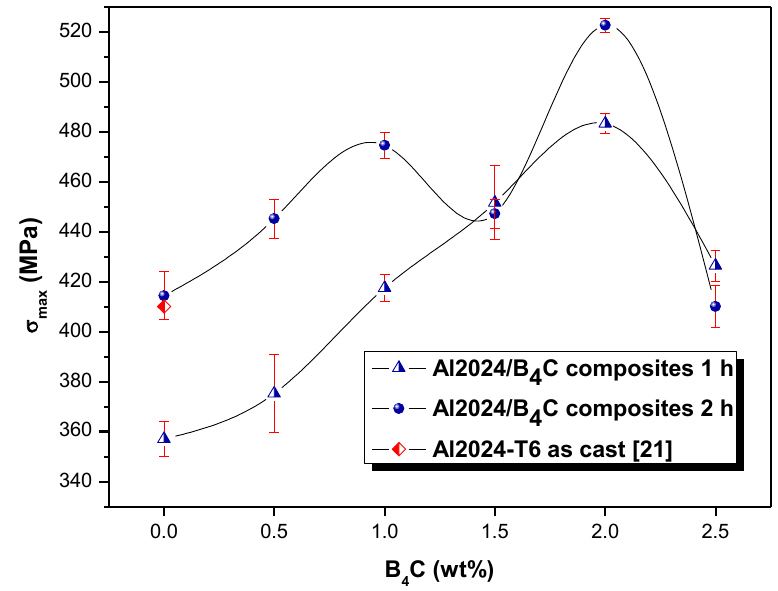
Figure 8. Maximum strength ( σ max ) as a function of the B 4 C content and milling time.